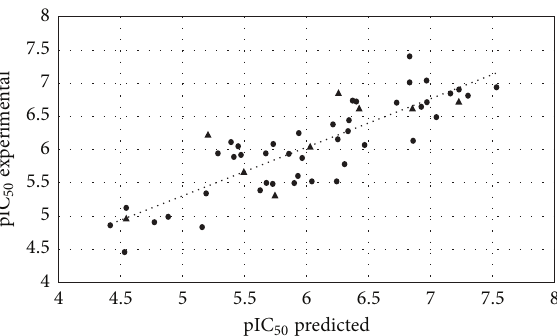
Figure 3: Plot of experimental versus predicted potencies using Ali5 0.01 3 for the training (circle) and test set